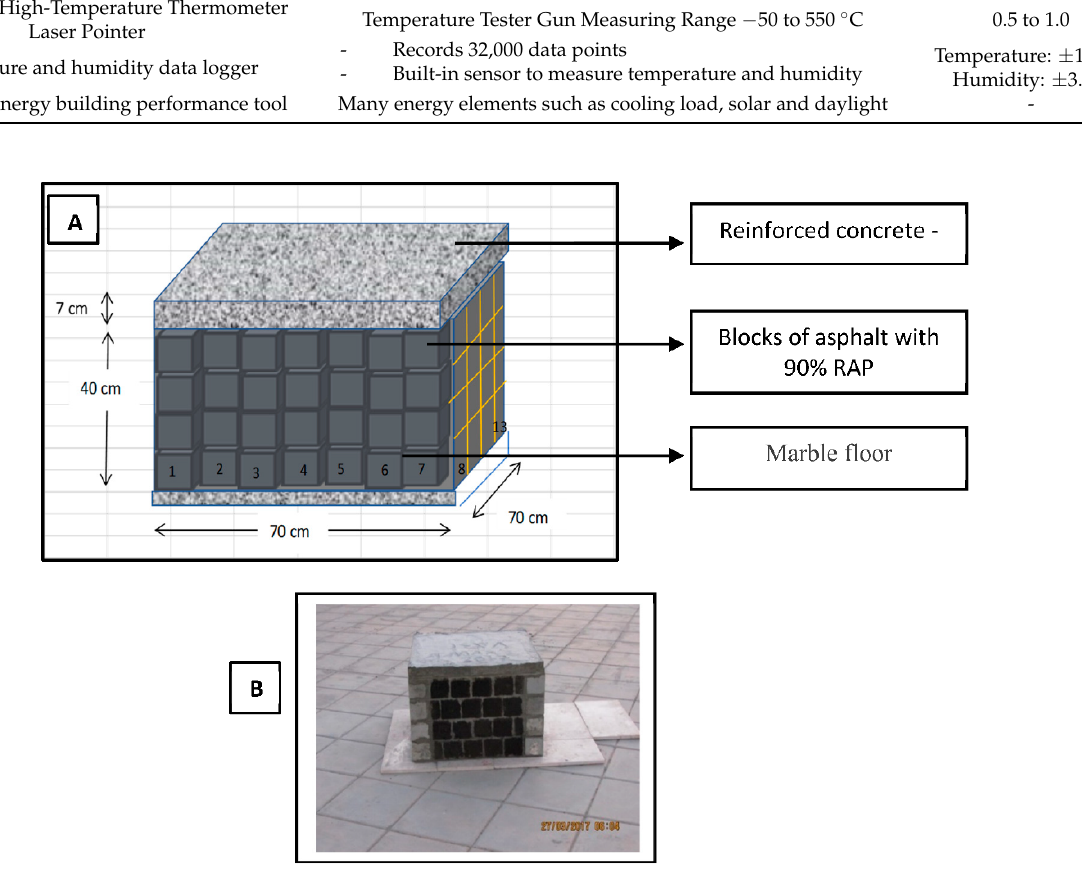
Figure 6. TAS EDSL model where: ( A ) is the 3D model with material specification and ( B ) is a view of actual model conducted on Taif University campus (Alwetaishi, Kamel and Al-Bustami, 2019) . Table 1. Tools and equipment used in the research study .